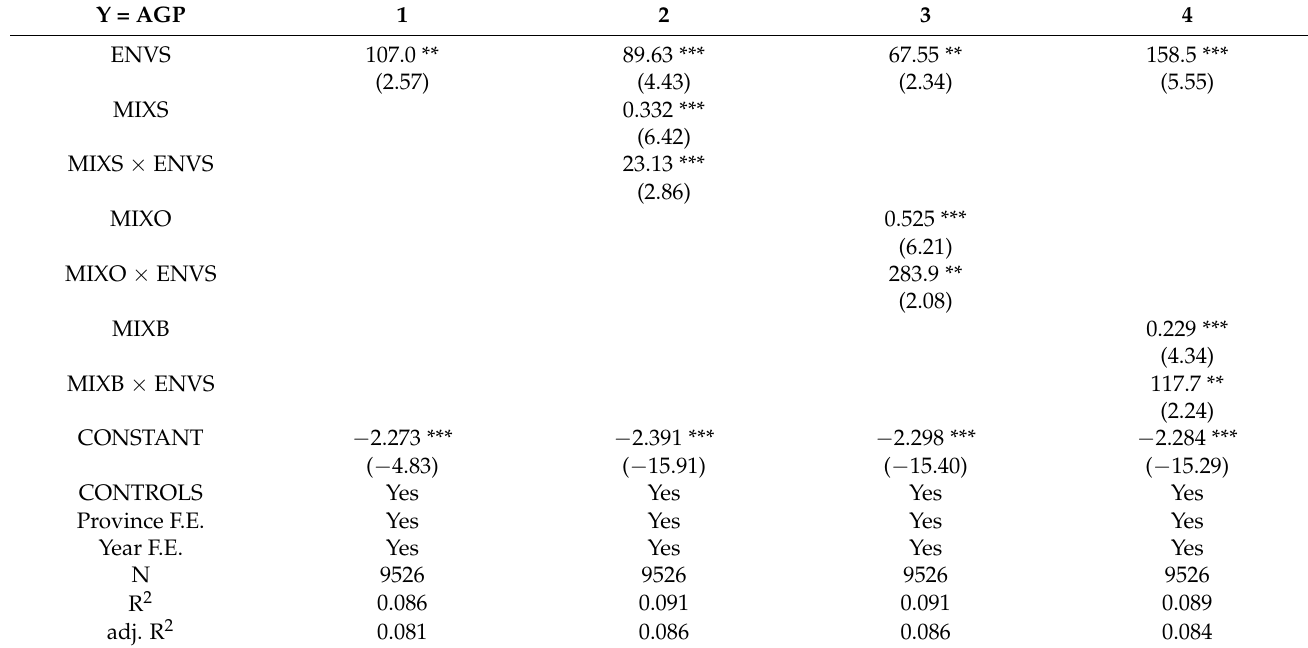
Table 9. The environmental protection subsidy mechanism